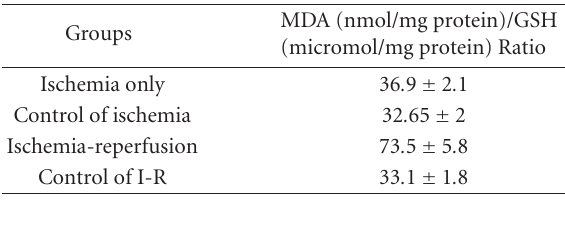
Table 2. Adipose tissue MDA/GSH ratios in groups are shown as mean ± standard deviation.